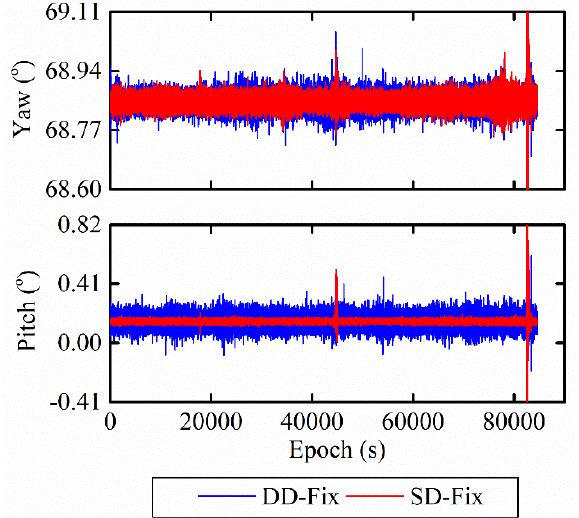
Figure 7. Waveform showing single-frequency and single-epoch attitude solutions between DD-Fix and SD-Fix after multipath mitigation. Table 4. STDs of yaw and pitch angles between DD-Fix and SD-Fix after multipath mitigation /° .